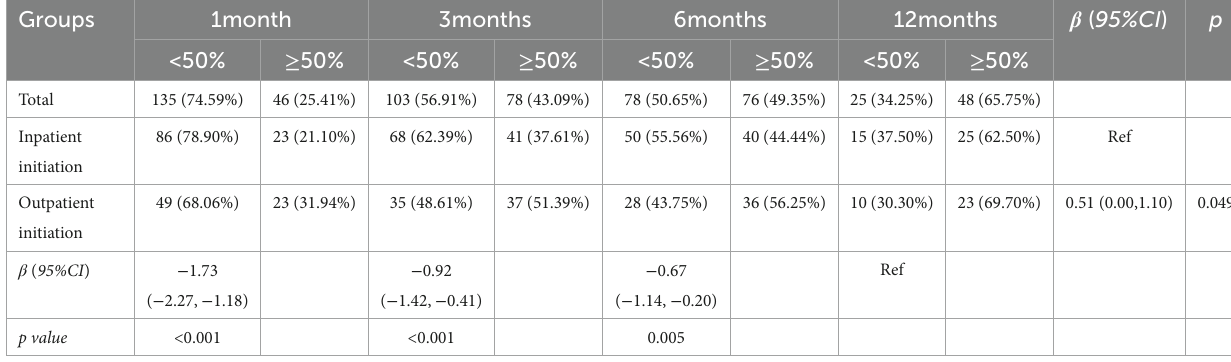
TABLE 2 Comparison of the efficacy in the different groups and follow up times based on the GEE. Groups